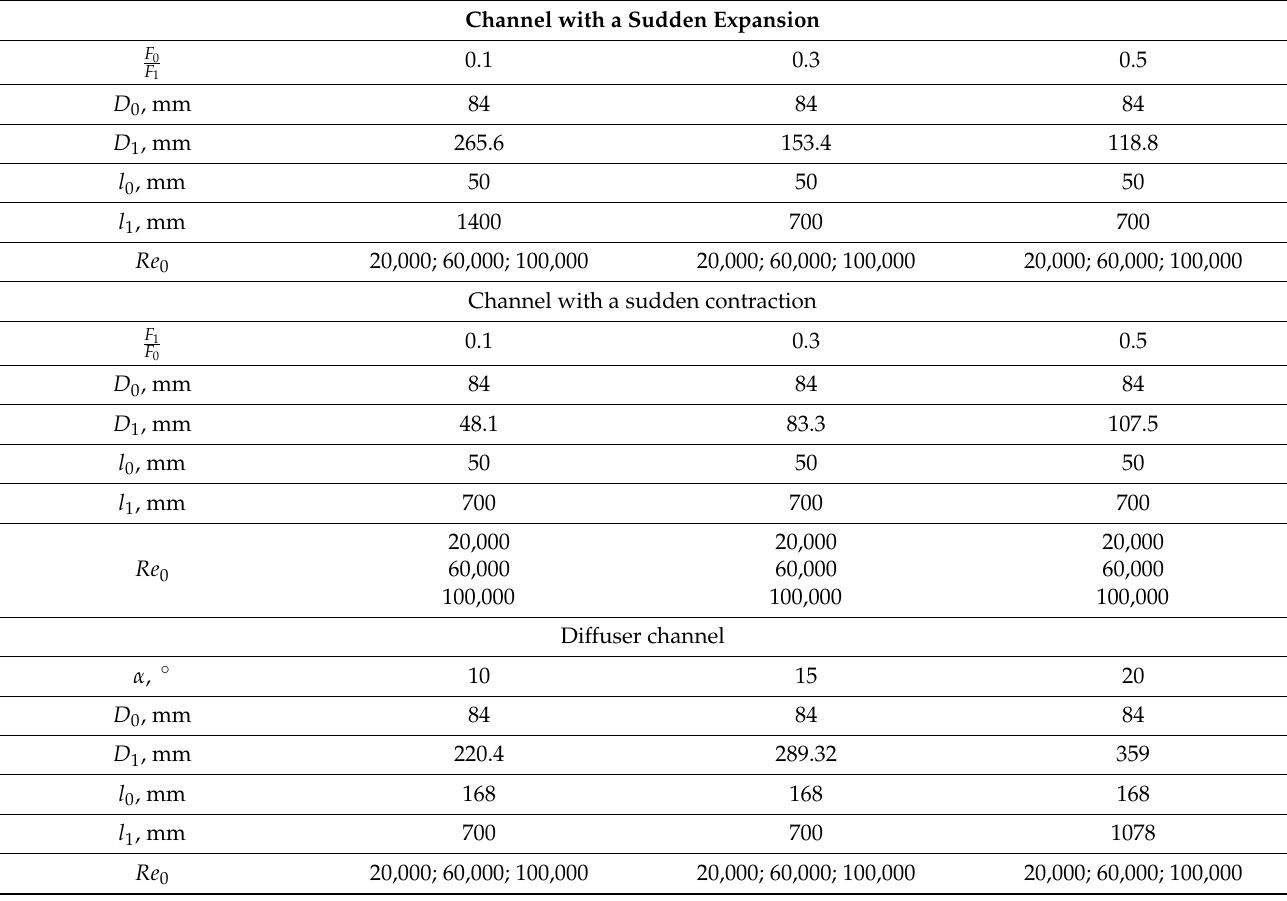
Table 1. Geometrical and operating characteristics of the studied channels.